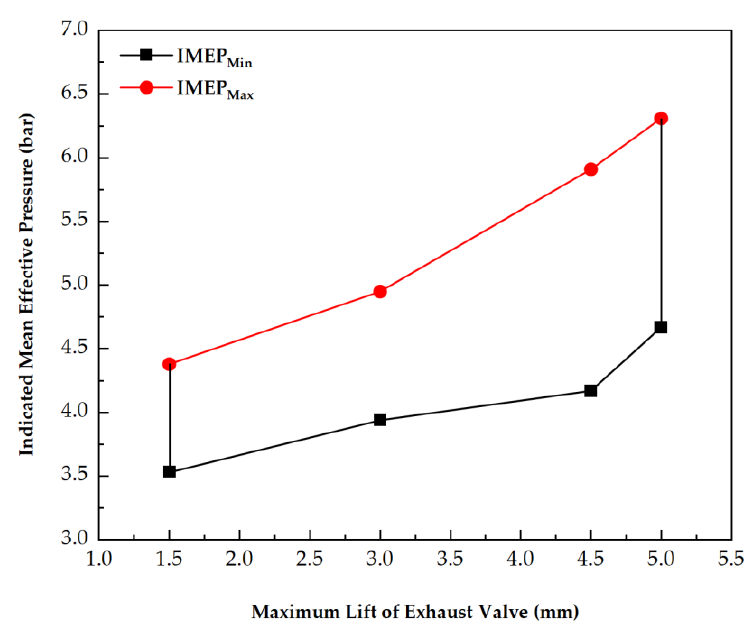
Figure 5. The range of IMEP under different exhaust valve lifts at 1000 rpm.